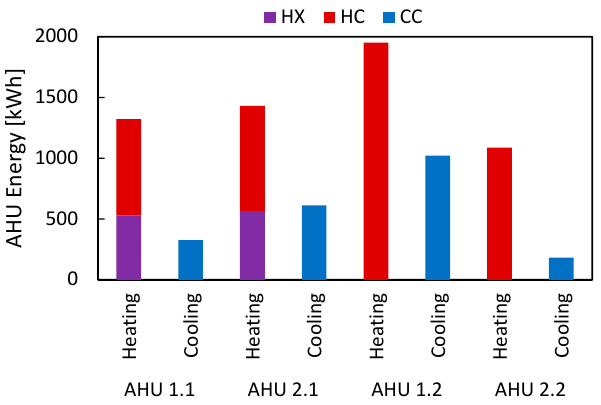
Figure 15. Total heating and cooling energy consumption of each AHU for the selected 24 h period.